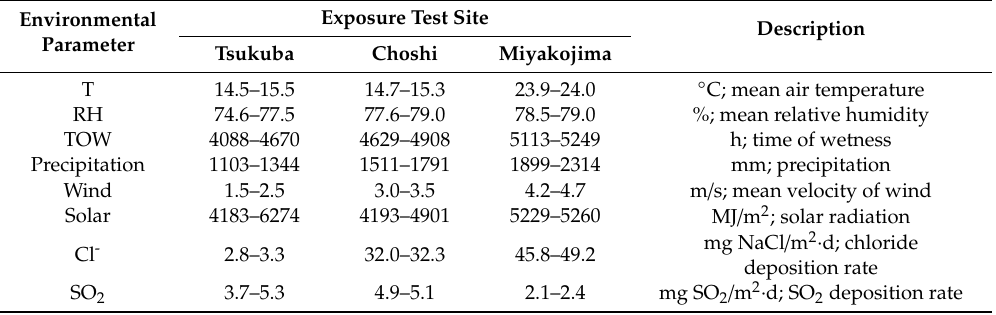
Table 2. Annual mean environmental parameters of all the 1-, 2-, 3- and 10-year specimens at the three atmospheric exposure test